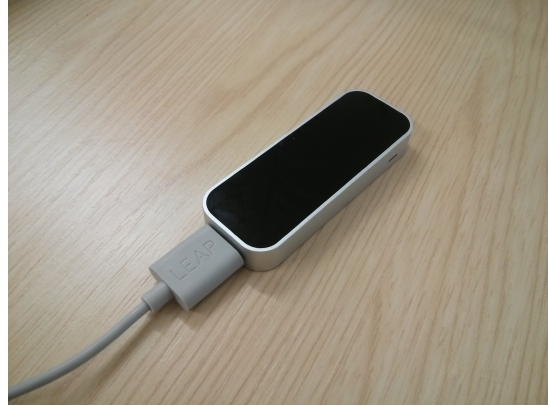
Figure 2. The Leap Motion input device used in the experimental